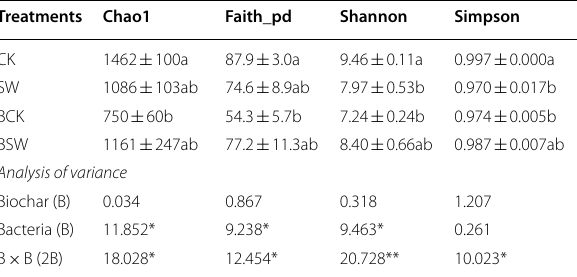
CK: control; SW: soil treated with 1%-biochar; BCK: soil treated with S. pasteurii ; BSW: soil treated with S. pasteurii and 1%-biochar. Data are mean Different letters indicate significant differences at p < 0.05 level. * , ** and *** indicate significant at p < 0.05, 0.01, and 0.001, respectively